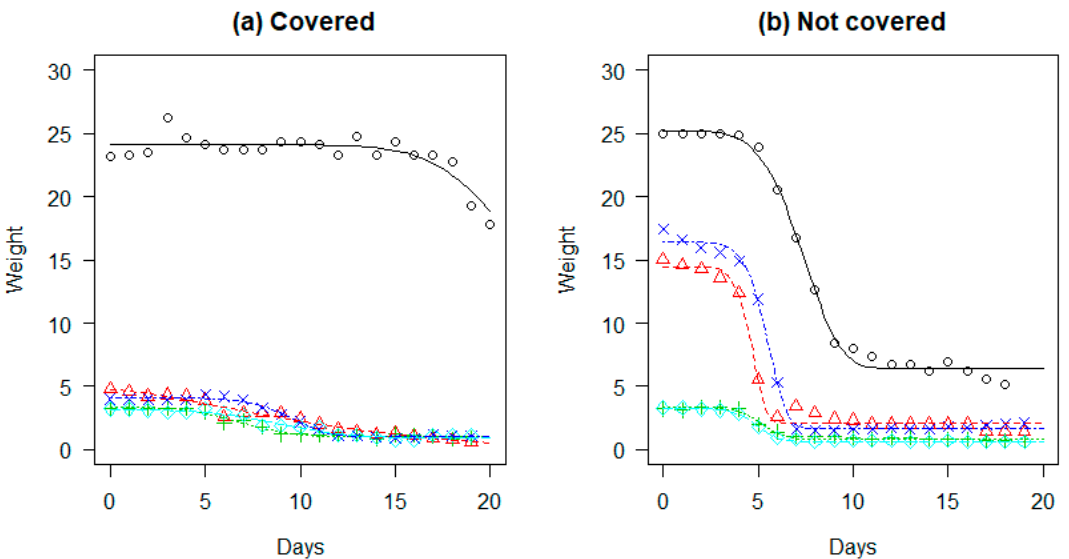
Figure 3. Daily weight variation (kg) and fitted Weibull curves describing the decay process of ( a ) five covered, and ( b ) five uncovered paired roe deer carcass or parts placed in a metal cage to exclude vertebrate scavengers during summer in South-Eastern Norway. The line in black in ( a , b ) are whole carcasses; the other lines are parts.